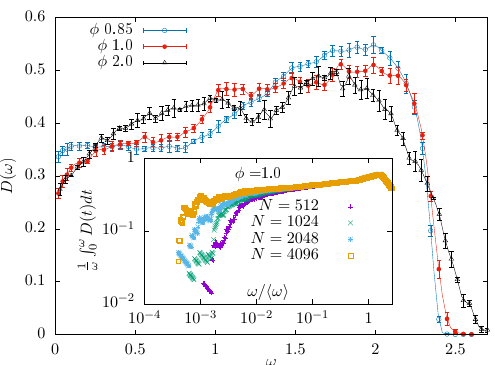
Figure 6: Density of states (DOS) of the elastic part of the Hessian matrix of the regularized potential, see Eq. (6), for different packing fraction above jamming in d = 2 and with N = 4096, averaged over 44 samples for φ = 0.85, over 42 samples for φ = 1.0, over 48 samples for φ = 2.0. Inset: the finite size behavior of the left tail of the DOS is consistent with having a finite value for D ( ω = 0 )